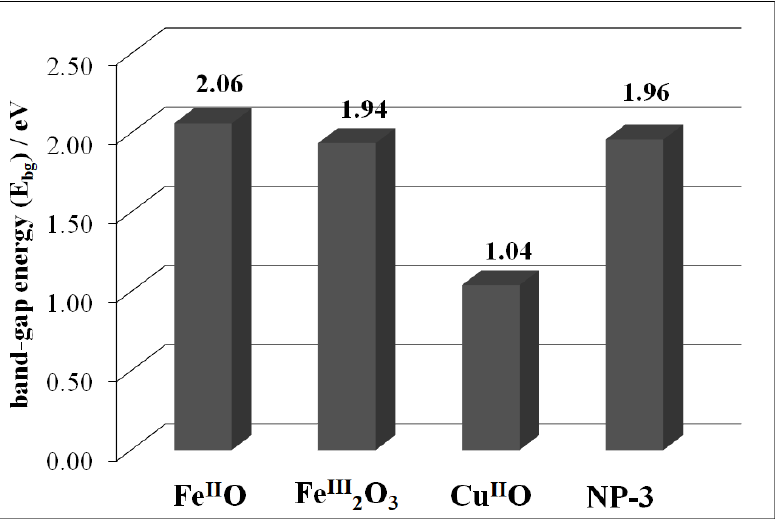
Figure 5. Comparison of band-gap energies (E bg ) of the simple metal oxides and NP-3. NP-3 showed the band-gap energy of 1.96 eV. In the earlier published literature, Fe III2 O 3 displayed a slightly higher band-gap energy (2.0 eV) [44] and the same trend was observed for Cu II O (1.2 eV) [45]. Lower band-gap energy is the key to absorb larger portion of sunlight, which is beneficial in photo-Fenton degradation.